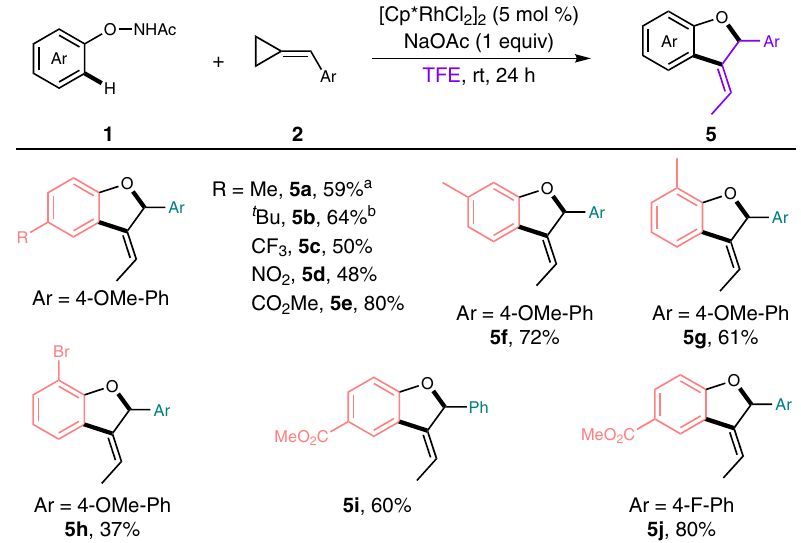
Fig. 4 TFE-tuned [3 + 2] annulation for the selective synthesis of 3-ethylidene 2,3-dihydrobenzofurans. Reaction conditions: 1 (0.2 mmol), 2 (0.4 mmol), [Cp*RhCl 2 ] 2 (5 mol%) and NaOAc (1 equiv) in TFE (0.2 M) at room temperature for 24 h under air, isolated yields were reported. a An inseparable mixture of two isomers was obtained, the ratio was determined to be 7.5/1 by 1 H-NMR analysis. b An inseparable mixture of two isomers was obtained, the ratio was determined to be 12/1 by 1 H-NMR analysis.